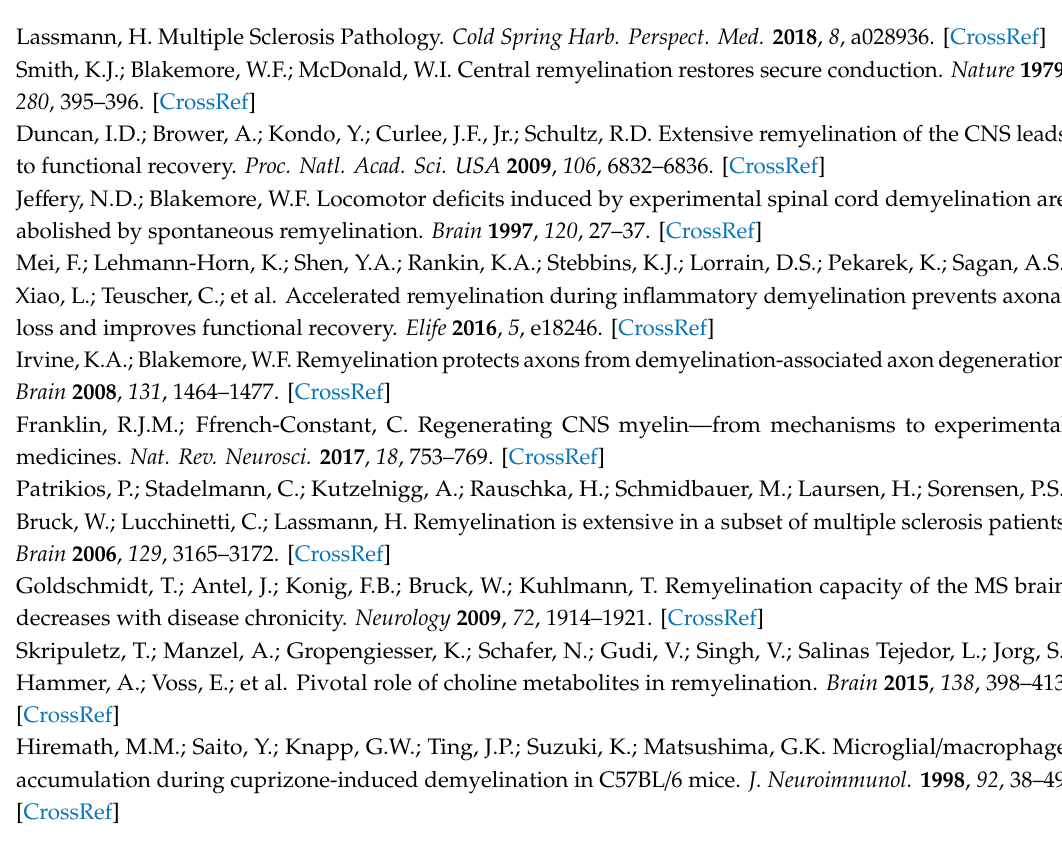
Figure S1. Experimental design, Figure S2. MBP loss in the corpus callosum of aged mice after di ff erent cuprizone treatment protocols, Figure S3. Depletion of NOGO-A-positive mature oligodendrocytes during demyelination in the midline of the corpus callosum of aged mice, Figure S4. Accumulation of microglia during demyelination in the medial corpus callosum of aged mice, Figure S5. Changes of di ff erent glia populations during demyelination in the lateral parts of the corpus callosum in aged mice, Figure S6. MBP re-expression during remyelination in the medial corpus callosum of aged mice, Figure S7. Repopulation of mature oligodendrocytes during remyelination in the central corpus callosum of aged mice, Figure S8. Decrease of microglia during the process of remyelination in the medial part of the corpus callosum of aged mice, Figure S9. Changes of myelin and glia cell populations during remyelination in the lateral parts of the corpus callosum in aged mice, Figure S10. Correlation of myelin changes and microglia reaction during de- and remyelination in aged